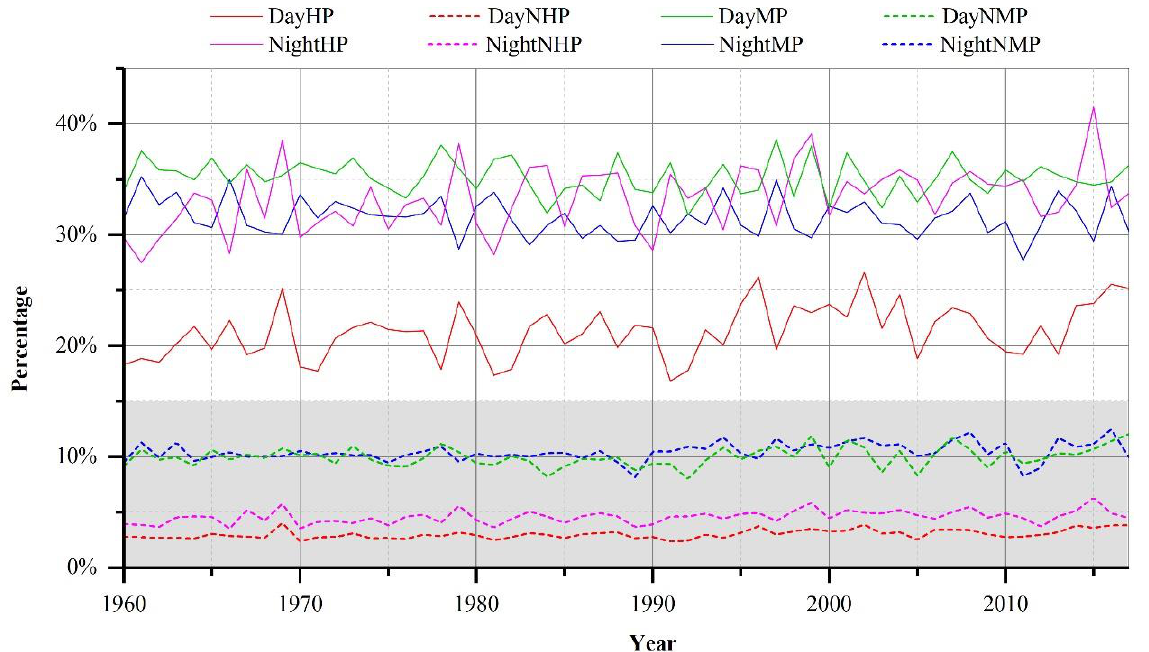
Figure 9. Comparison of the percentage of average precipitation and rainfall days. (HP: proportion of heavy precipitation, MP: proportion of moderate precipitation, NHP: number of heavy precipitation days, NMP: number of moderate precipitation days).